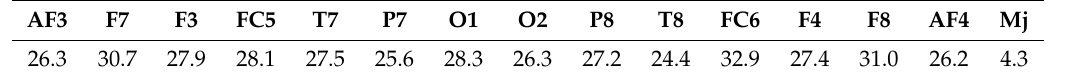
Table 5. EERs (%) when fusing nonlinear features. Mj, majority